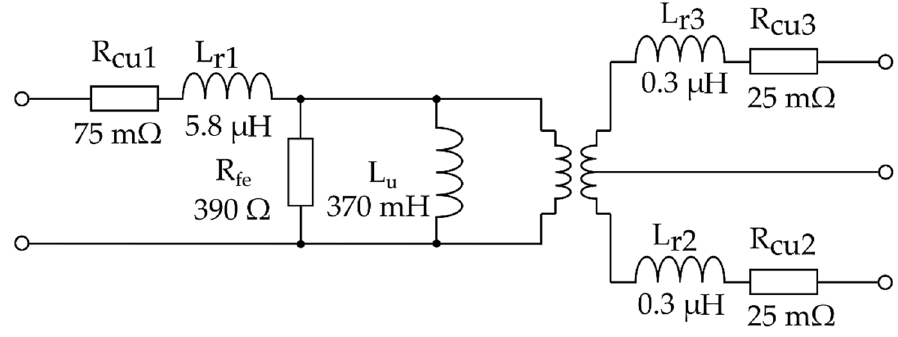
Figure 19. The equivalent circuit of real IT pulse transformer (R cu -resistance of the windings, R fe - resistance representation of the iron core losses, L r -inductance of the windings, L u -main